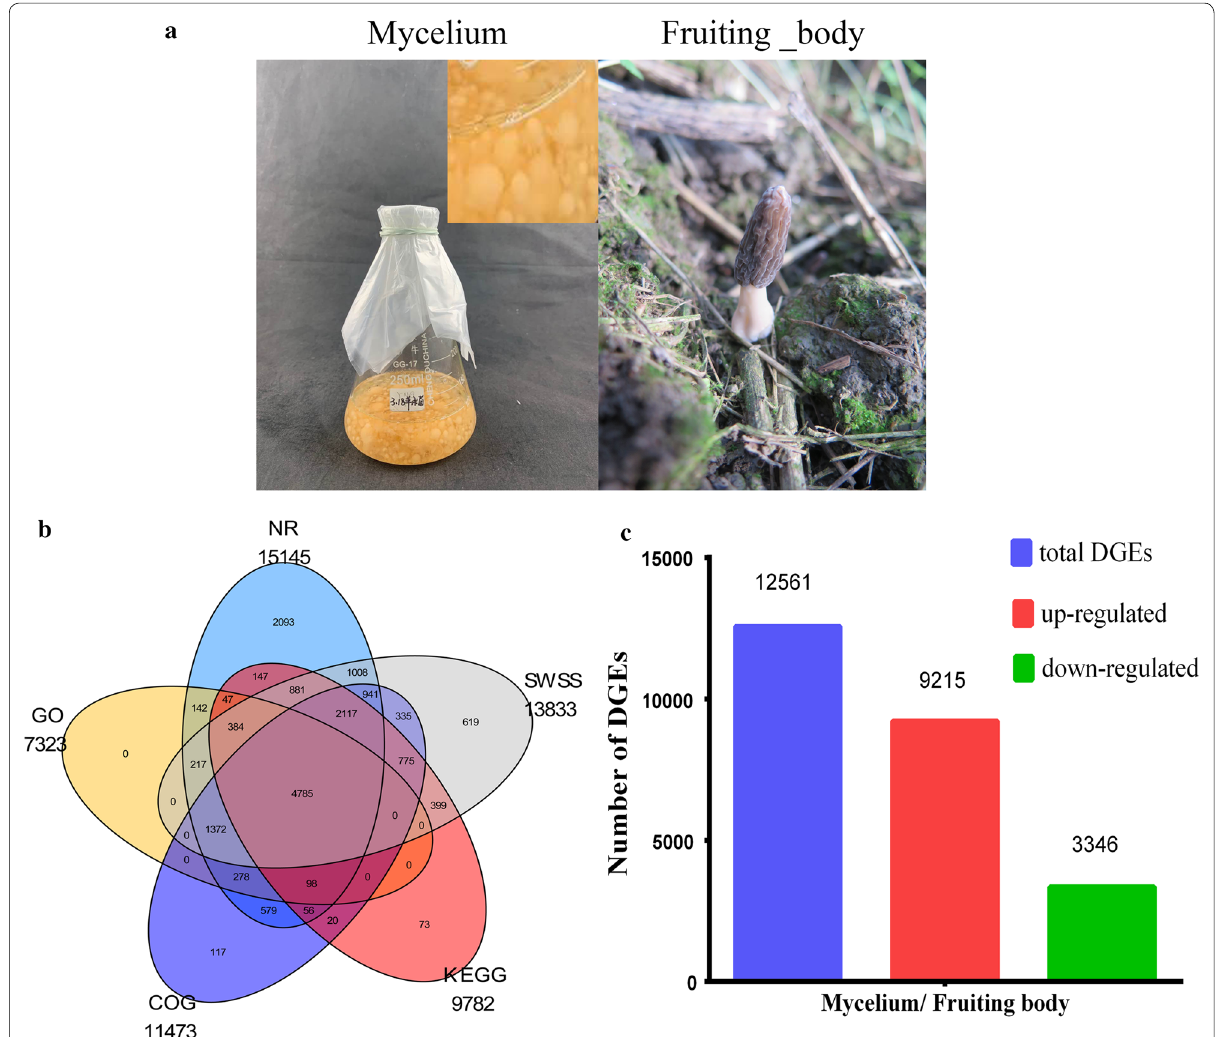
Fig. 1 Summary of transcriptome annotation and differentially expressed genes (DEGs) between the M. importuna mycelium and fruiting body. a Representative pictures of a liquid shake flask culture of M. importuna mycelium at 7 days (left) and an artificially cultivated young fruiting body at 80 days (right). b A total of 33,269 unigenes, among which 15,145 (45.52%) were annotated in the NR database, 13,833 (41.58%) were annotated in the SWSS database, 11,473 (34.49%) were annotated in the COG database, 7323 (22.01%) were annotated in the GO database, and 9782 (29.4%) were annotated in the KEGG database. c The histogram shows the expression levels of 12,561 DEGs in the young fruiting body compared to the mycelium. The blue areas represent the total DEGs, the red areas represent DEGs that showed upregulated expression, and the green areas represent DEGs that showed downregulated expression